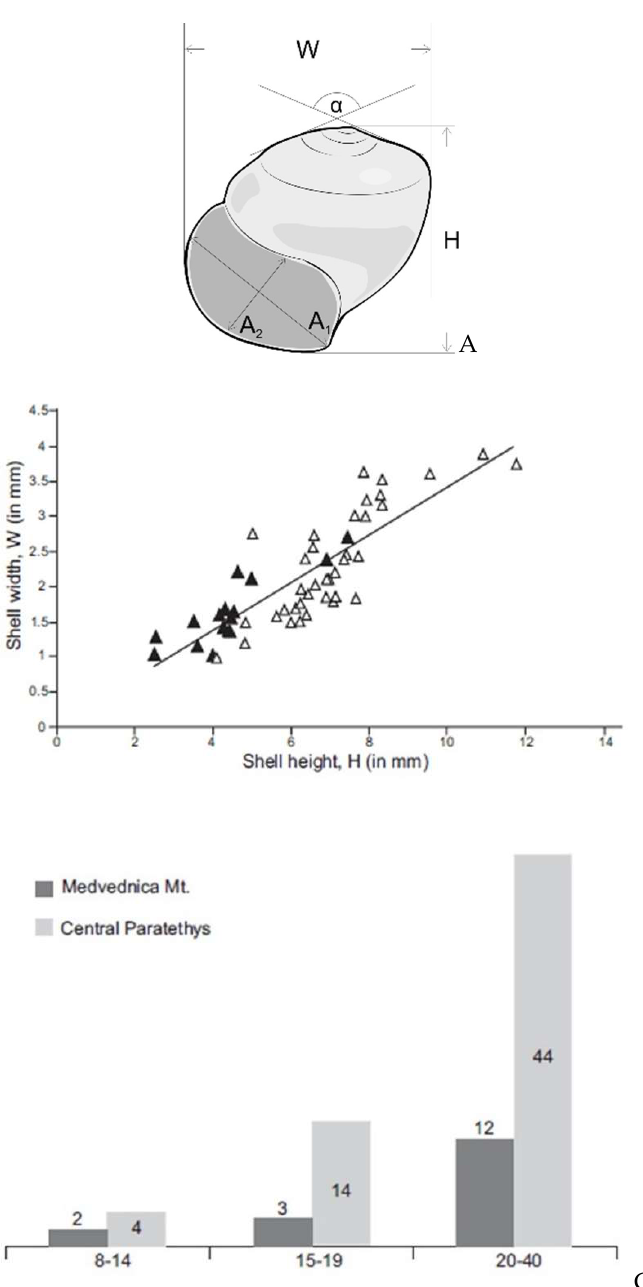
Figure 9. Morphometric characteristics and comparison of the planktic gastropods between different localities based on the measured morphometric elements of the shell (after [55] ) . A : Measured parameters on the gastropod shell: H (height of the shell), W (width of the shell), α (apical angle), A 1 and A 2 (aperture diameters). B. Comparison of planktic gastropod from different areas (black and white triangles) based on the measured values of the shell height and width. C. Comparison of planktic gastropod species from different areas (dark and light grey columns) based on the measured values of the apical angle of the gastropod shells.